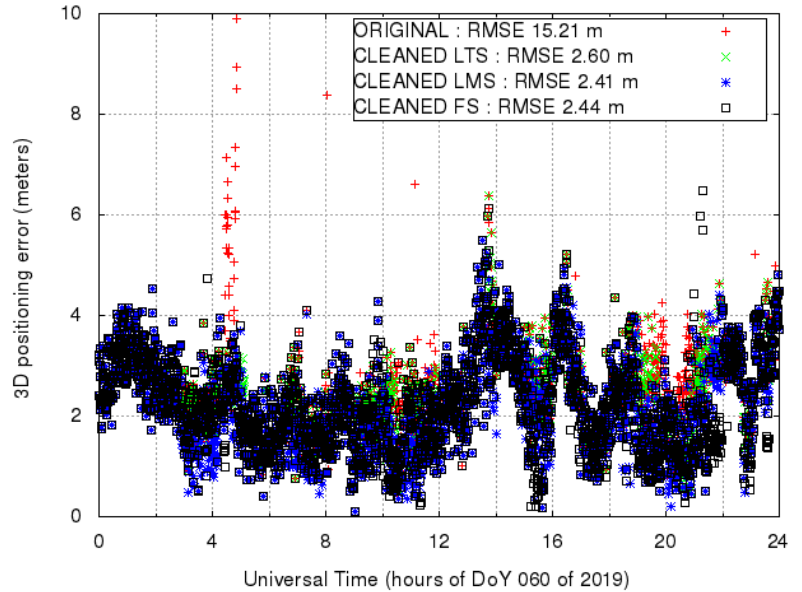
Figure 8. Zoom of Figure 7 for positioning errors smaller than 10 m. 3D position errors of HUEG using the SPP. In red, the original PVT obtained without detecting outliers. The PVT obtained after removing the outliers detected by LMS (blue), LTS (green) and FS